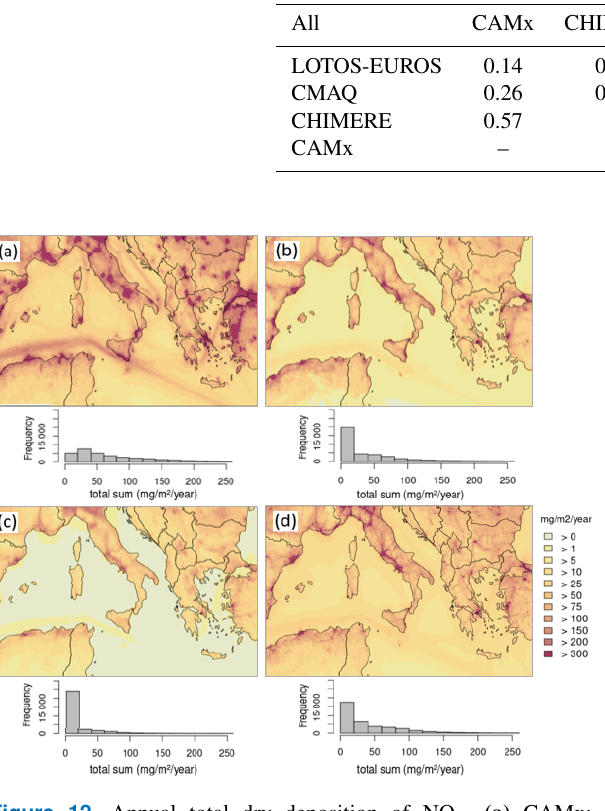
Figure 13. Annual mean dry deposition of NO 2 relative potential ship impact. (a) CAMx; (b) CHIMERE; (c) CMAQ; (d) LOTOS- EUROS. Below the domain figure the respective frequency distribu- tion is displayed for the annual mean NO 2 dry deposition potential ship impact, referring to the whole model